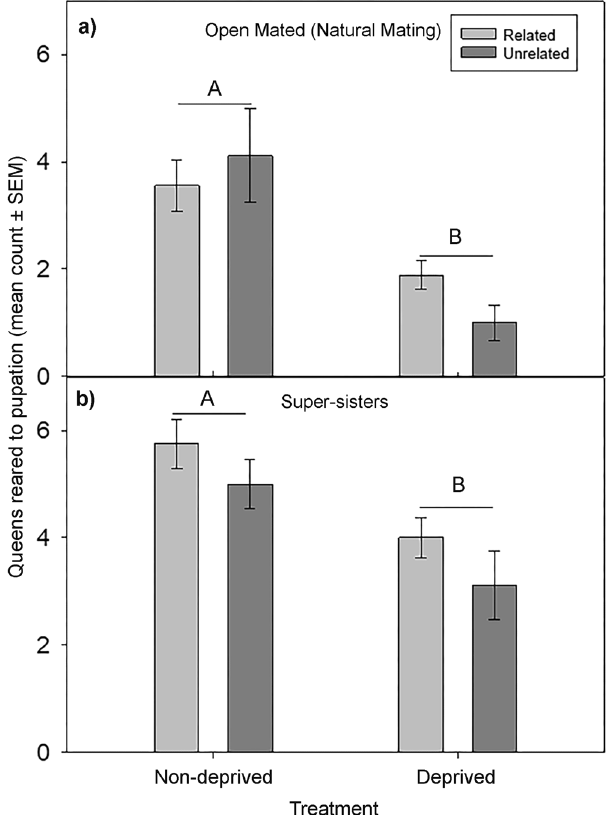
Figure 4. Figure portrays larval selection for queens by workers between related and unrelated colonies having queens which are open mated and queens which are super-sisters (mated by only single drones) based on larval deprivation. No significant difference was observed in the number of queens reared to pupation in both ( a) open mated (natural mating) and ( b ) super-sister colonies with respect to related (light grey) and unrelated colonies (dark grey). However a significantly higher number of queens were reared to pupation from the non- deprived treatment groups when compared to the deprived group in both ( a ) open mated (p < 0.0001) and ( b ) super-sister colonies (p < 0.05). Bars indicate SEM. N = 2 as the data was pooled for each group. For all variables with the same letter (A or B), the difference between the means is not statistically